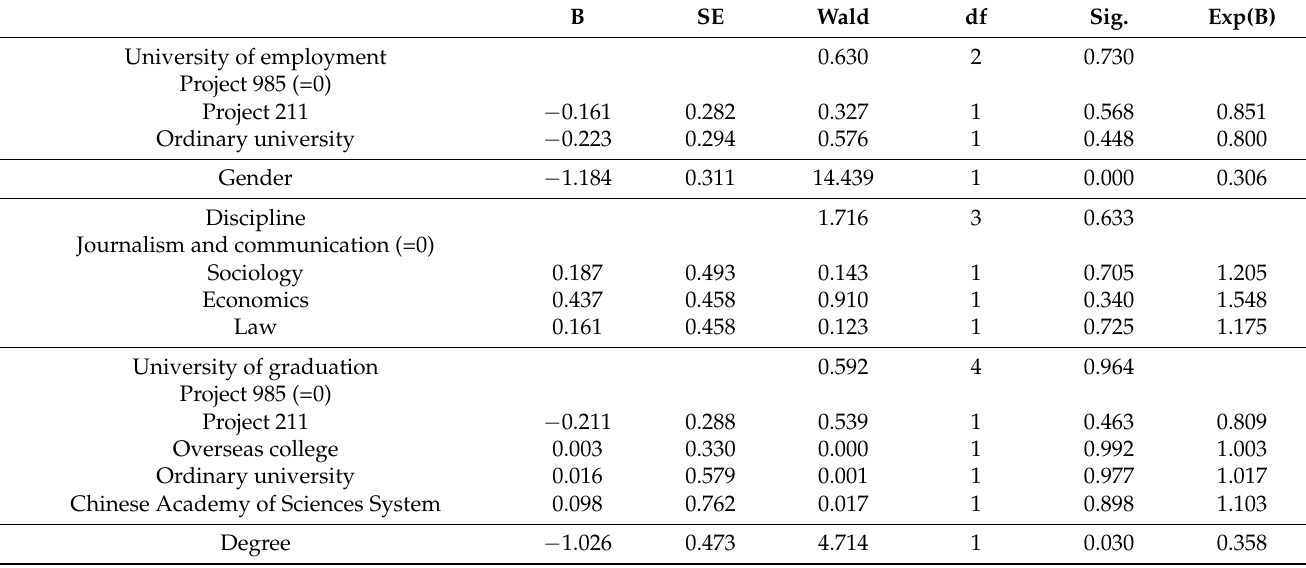
Table 5. Cox Model Results (Associate to Full